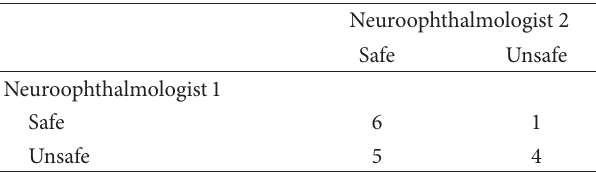
Table 2: Predictions of driver safety by the two neuroophthalmolo-